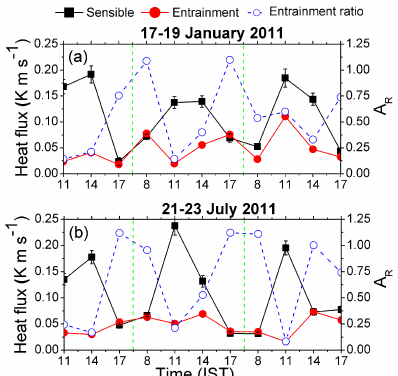
Figure 8. Sensible and entrainment fluxes (left axis) and entrain- ment ratio (right axis) estimated at ∼ 3h intervals during (a) 17– 19 January 2011 and (b) 21–23 July 2011, indicating the forcings on the ABL from the bottom and